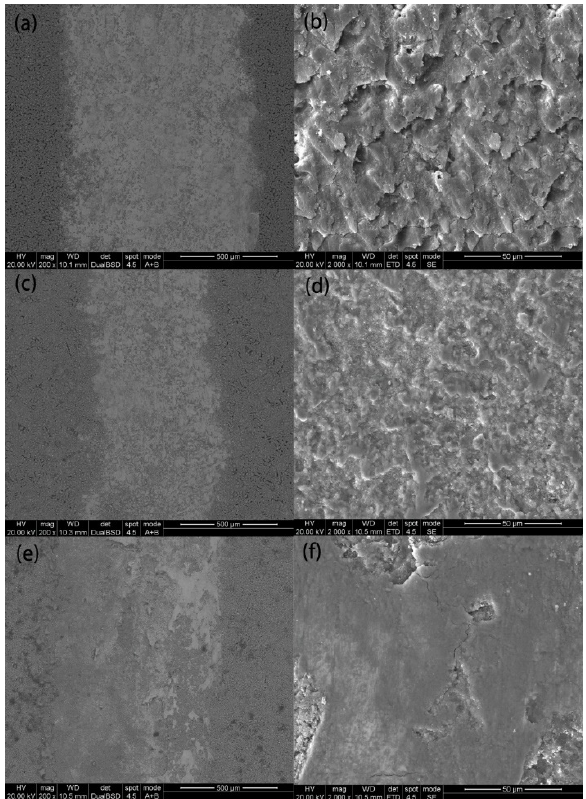
Figure 7. SEM morphologies of the wear tracks after 30 min of wear under 4 N: ( a , b ) coating A, ( c , d ) coating B and ( e , f ) coating C.